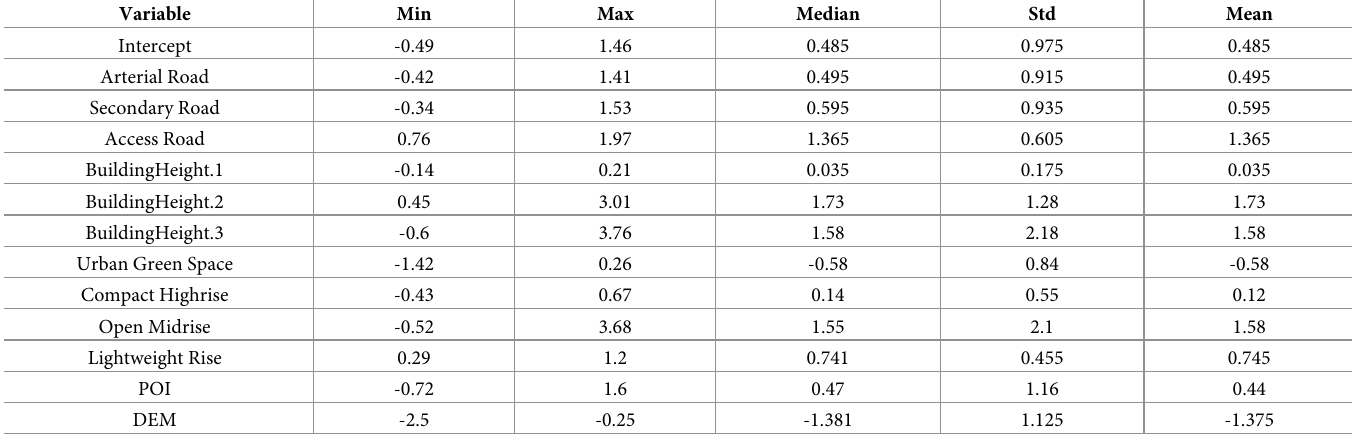
Table 8. Statistical description of MGWR